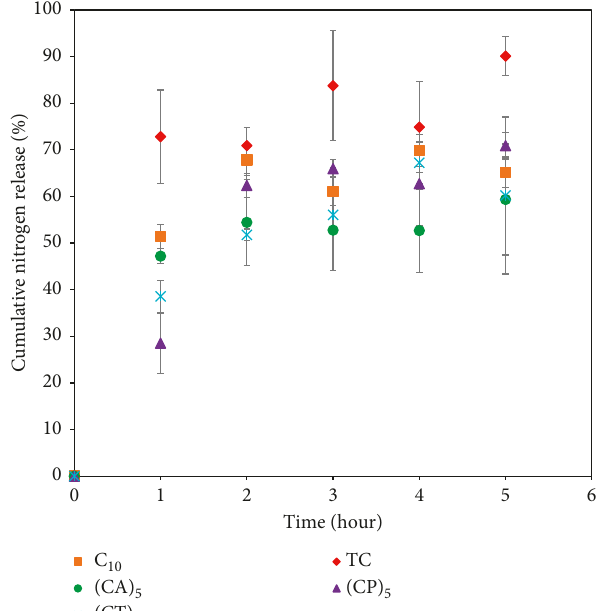
Figure 3: Effect of chitosan-polyion multilayer coating on the release of nitrogen.